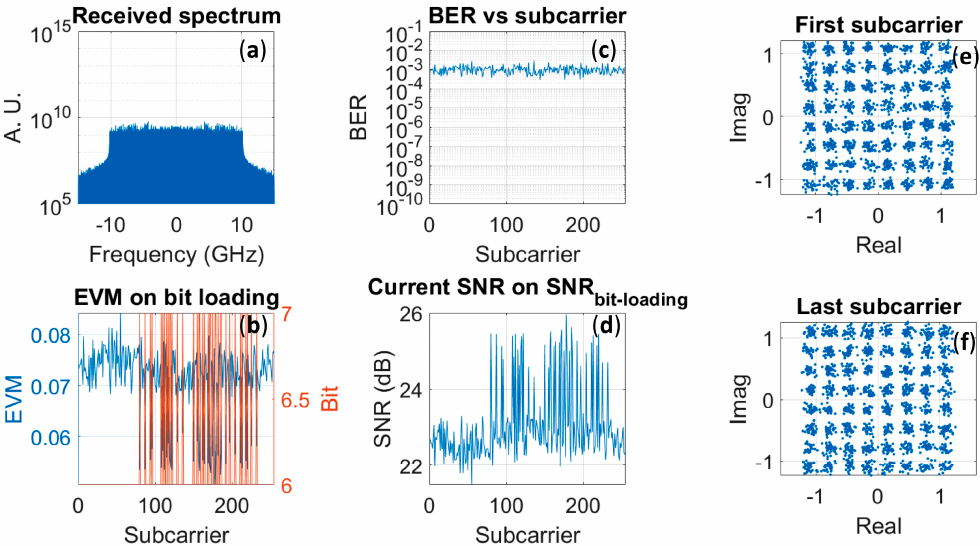
Figure 4. ( a – f ) Tunable VCSEL: DSB DMT (10 GHz) for single WSS filtering and 40-dB OSNR.